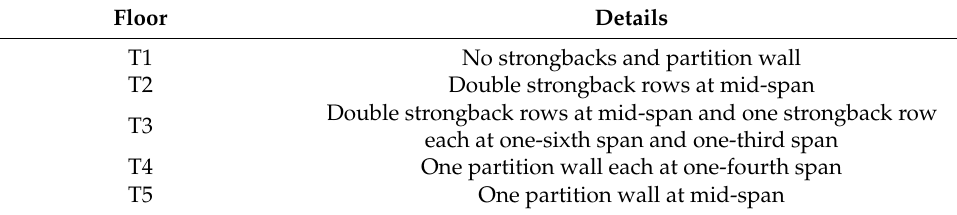
Figure 4. OSB layout.